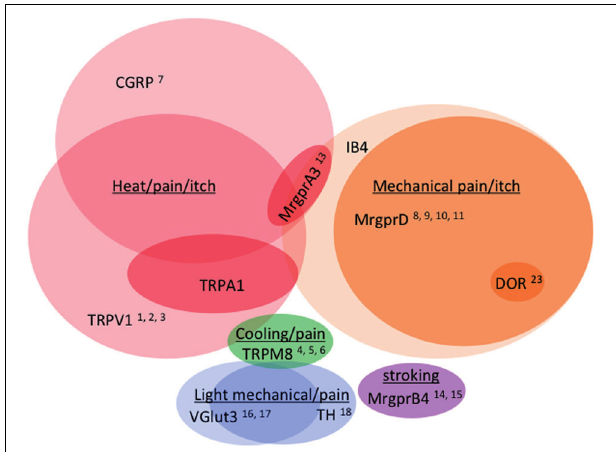
FIGURE 4 | Venn diagram illustrating the distribution of markers across different classes of C fibers (not to scale). Numbers reference the mouse lines listed in Table 2